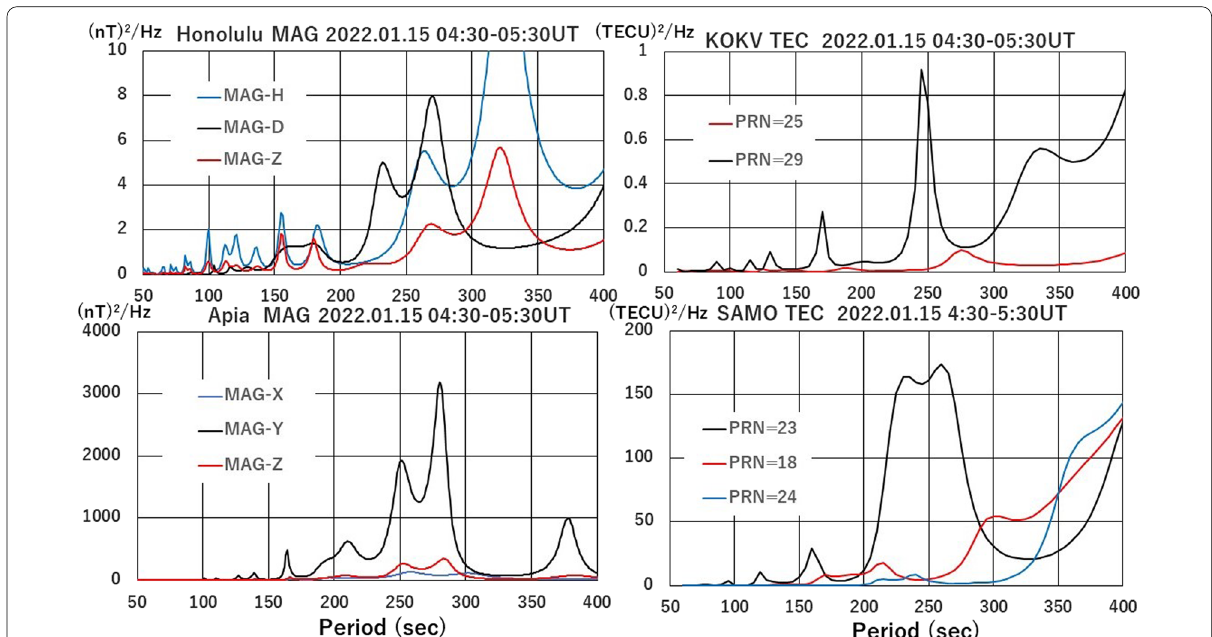
Fig. 7 A comparison of power spectral density (PSD) of geomagnetic variation and GPS-TEC variation observed in Hawaii (upper panels) and those observed in Samoa (lower panels). The data from 04:30 to 05:30 UT were used to obtain the PSD by the MEM method with lag